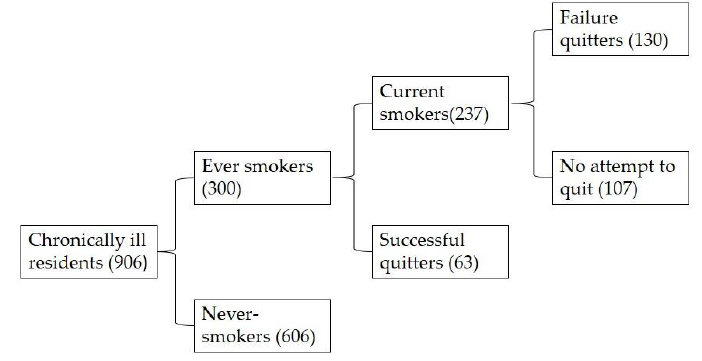
Figure 1. Chronically ill residents categorized by smoking conditions.